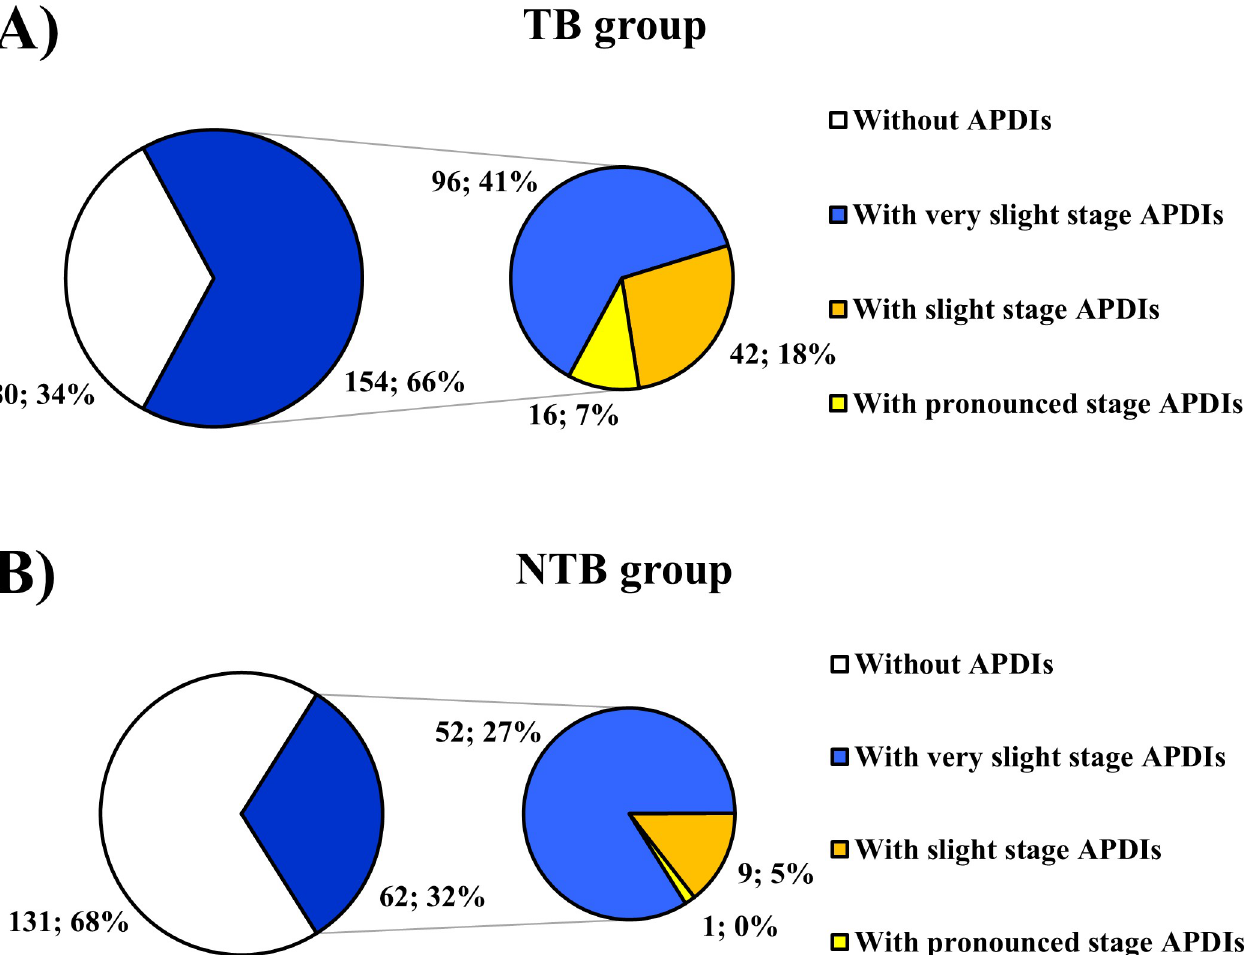
Fig 3. Distribution of the selected individuals from the Terry Collection by the presence of APDIs (considering the different stages of the prominence of lesions). A) Distribution of individuals who died of TB; and B) Distribution of individuals who died of NTB causes. (In both the TB group (A) and NTB group (B), the larger pie chart shows the distribution of all individuals by the presence of APDIs (i.e., not present (white) or present (dark blue)). Whereas, the smaller pie chart shows the distribution of individuals displaying APDIs by the prominence stage of the presented APDIs (i.e., very slight (light blue), slight (orange), and pronounced (yellow)). The percentage values were calculated with respect to the total number of individuals in both the TB group (N TB = 234) and NTB group (N NTB =